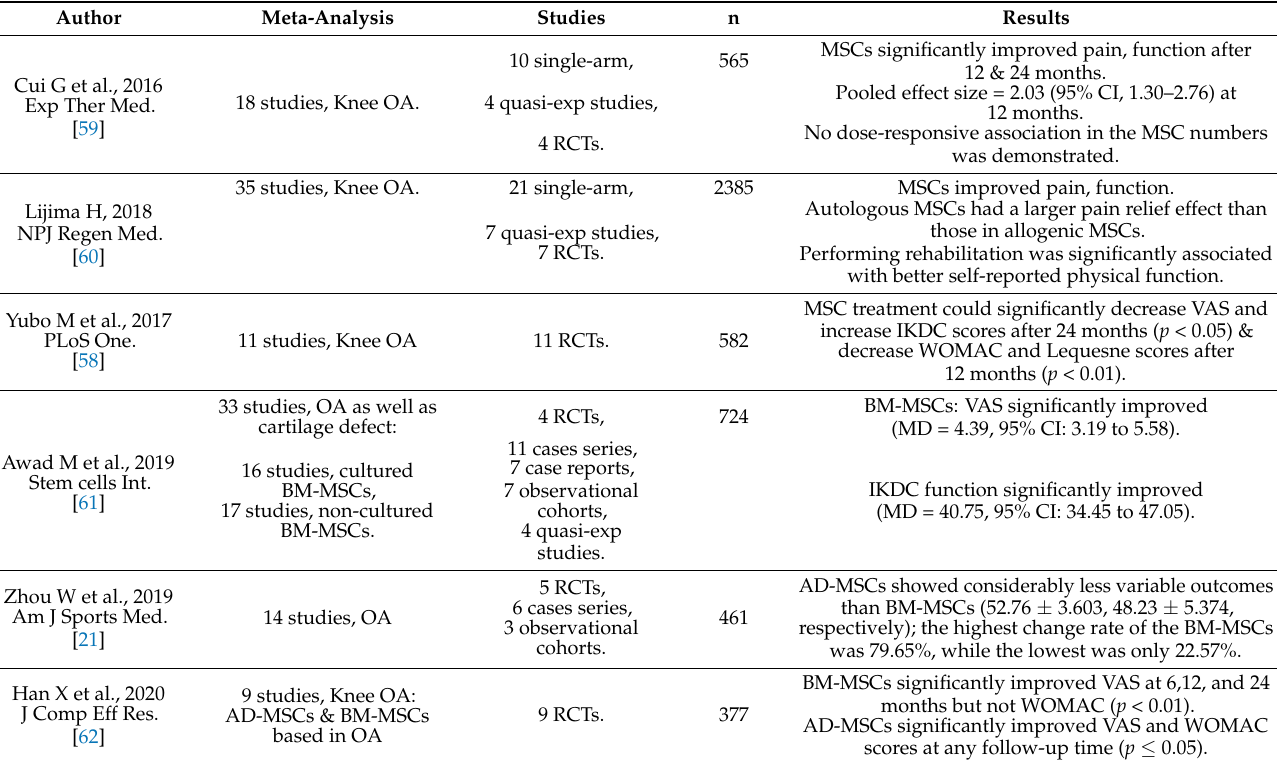
Table 1. Meta-analyses of MSC clinical application for